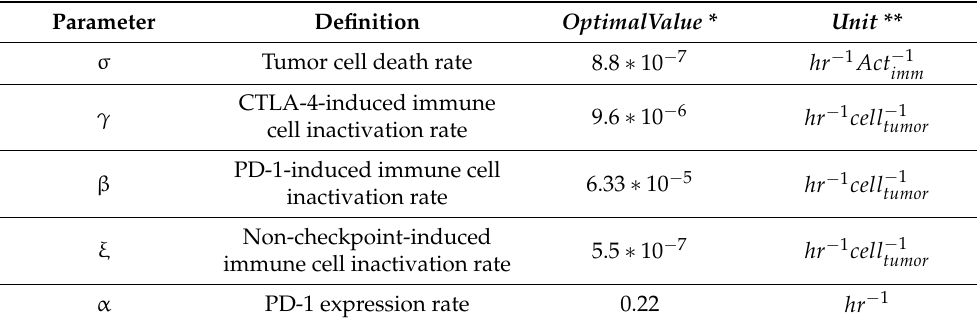
Table 1. Tumor–immune interaction parameters.